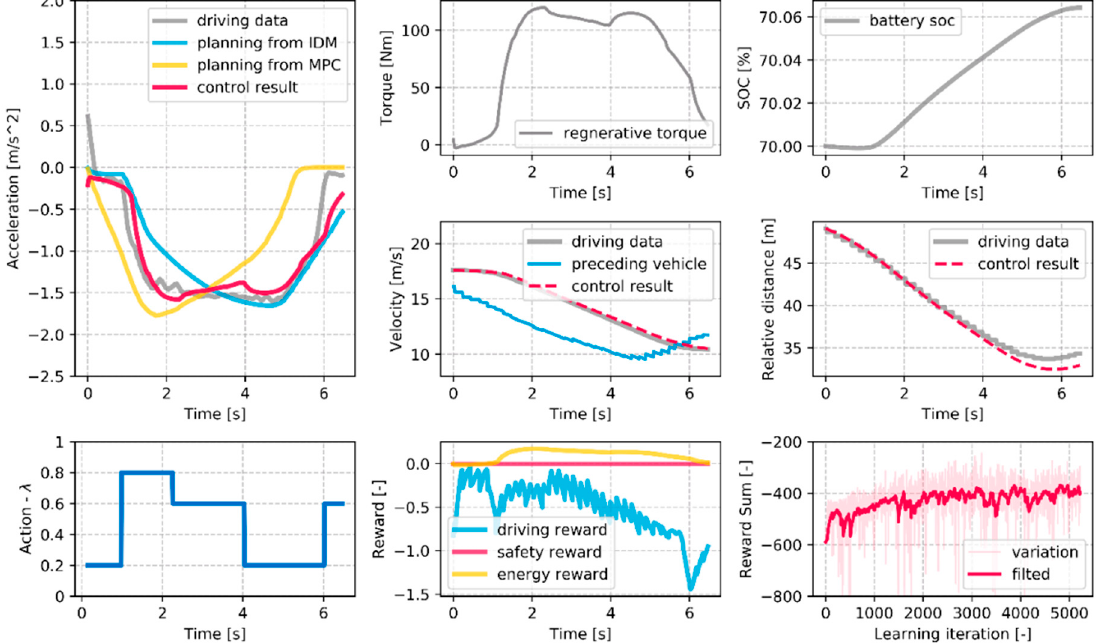
Figure 15. Learning and Regenerative control results for deceleration case.